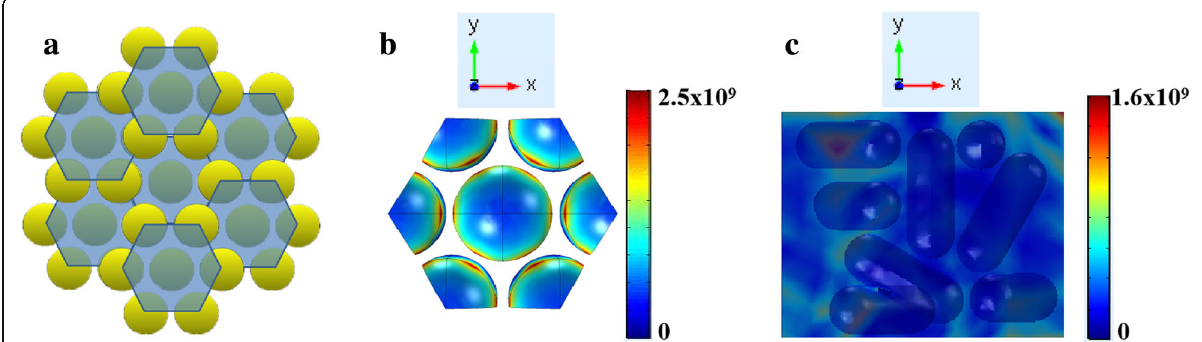
Fig. 5 a GNR hexagonal array simulation pattern. b Local electromagnetic field simulation results of GNR vertical arrays. c Local